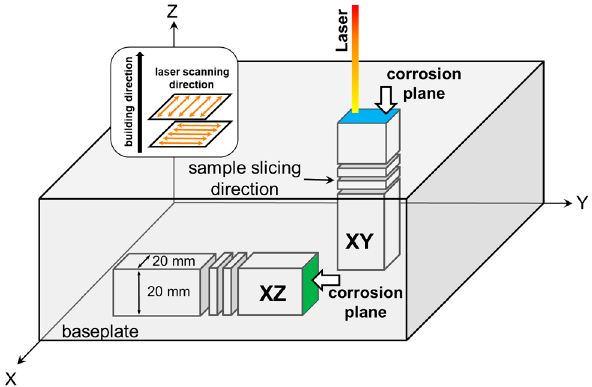
Figure 1. Schematic of sample geometries, scanning strategy, building direction, and corrosion test planes.